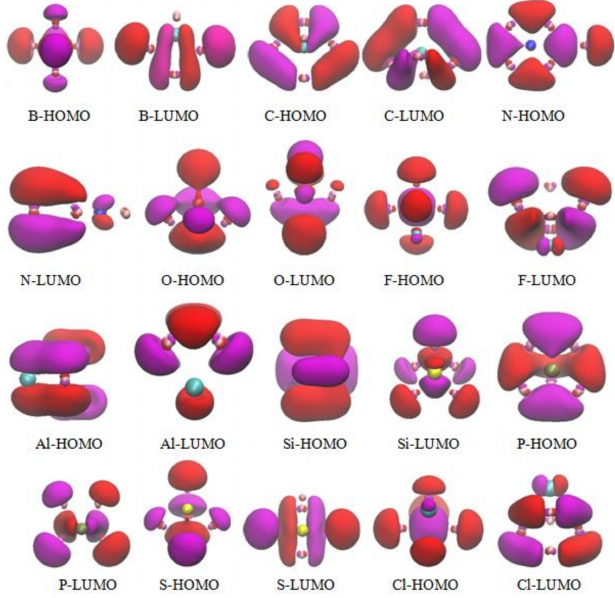
Figure 3. The molecular orbitals for the lowest energy structure of Ga 5 X (X = B, C, N, O, F, Al, Si, P, S, Cl)